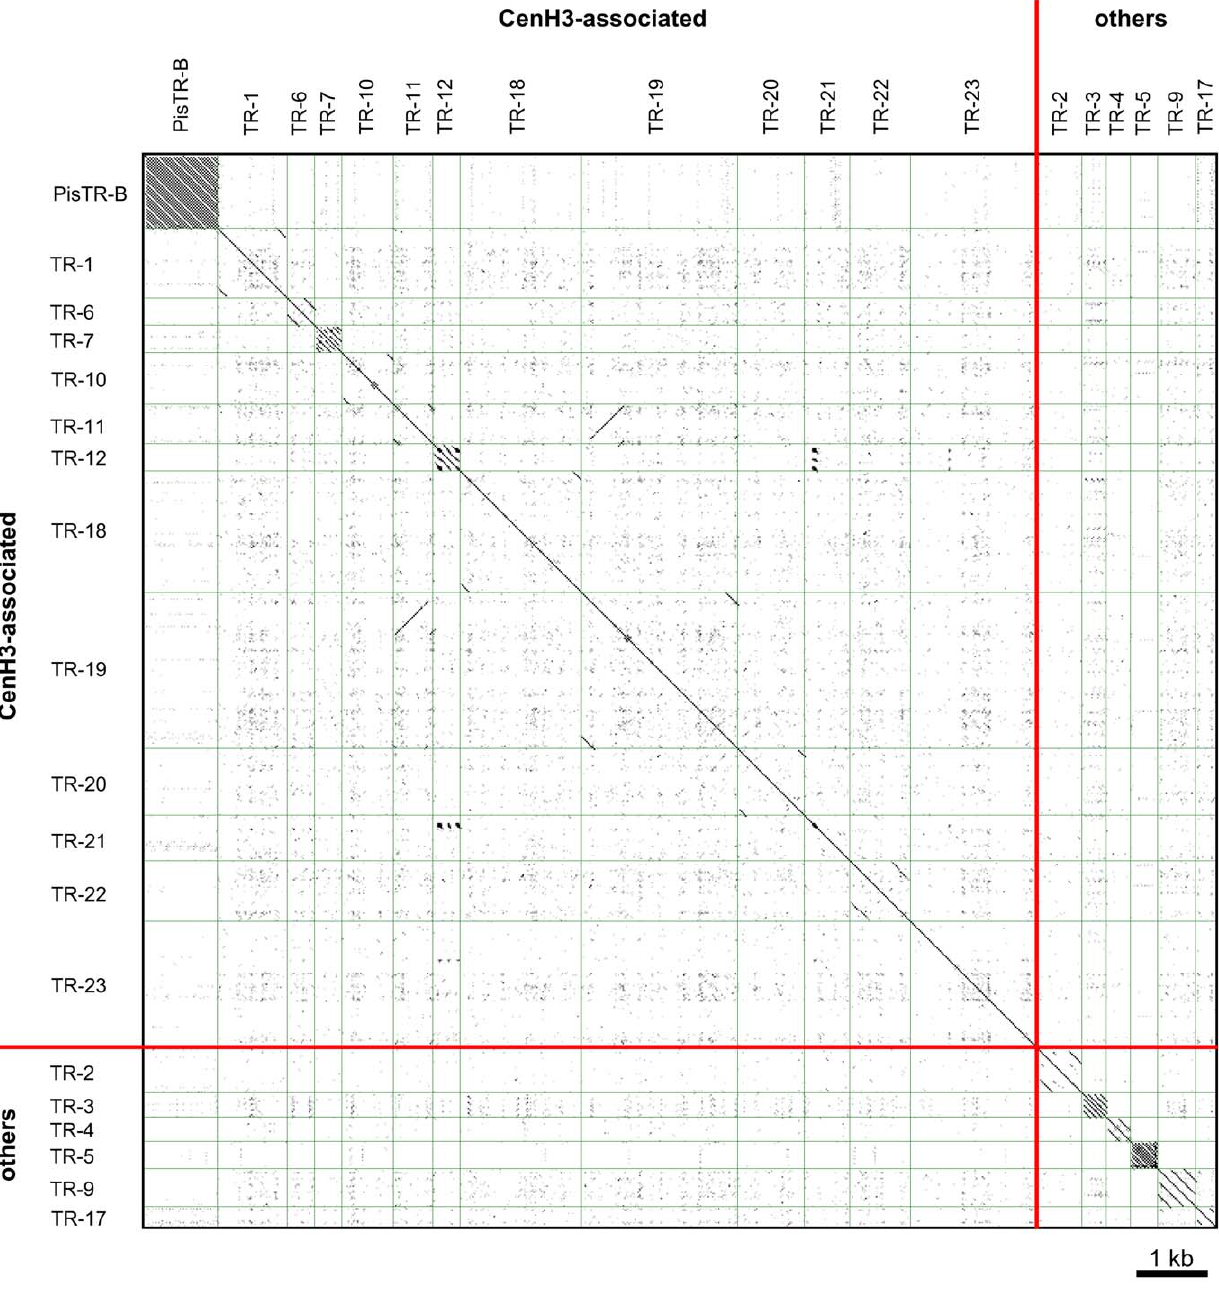
Figure 5. All to all dot-plot comparison of the pea satellite repeats. With exception of TR-11 and TR-19, the sequences of different satellite DNA families show no similarity. A fragment of long monomer of TR-19 shows high similarity to TR-11. FISH experiments revealed that all loci of TR-19 repeat contain also TR-11, but only some of TR-11 loci contain TR-19 (Figure 6 and data not shown), indicating that these two repeats should be considered as different families. Sequences used for dot-plot comparison are provided in Dataset